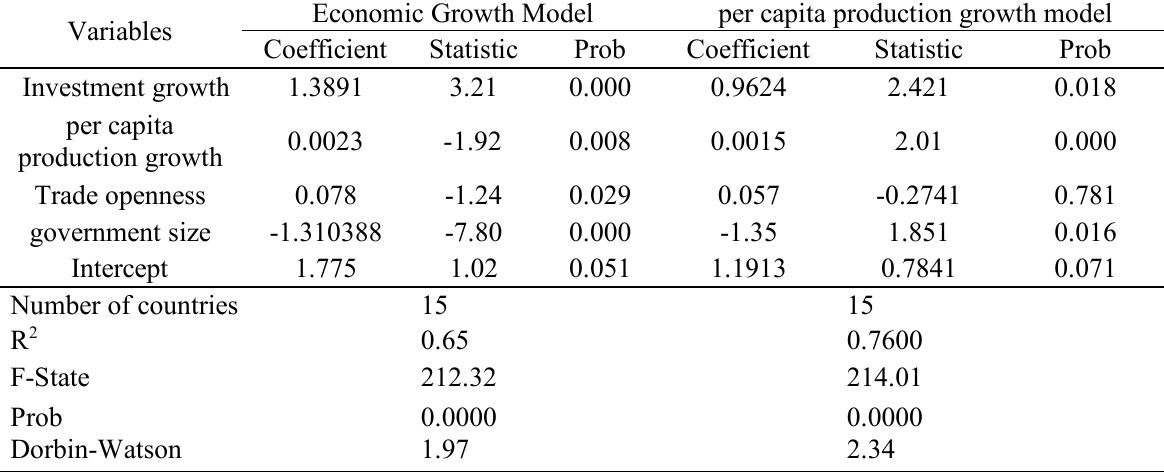
Table 5 . Results of Estimation of Two Patterns of Economic Growth and production growth per capita in Developing